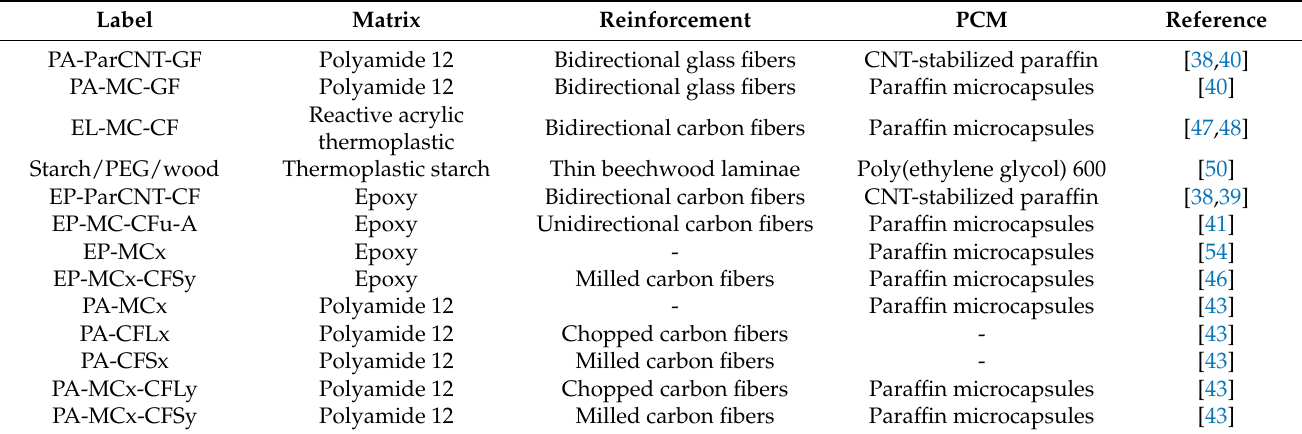
Table 3. Multifunctional composites under investigation in this paper with specifications of matrices, reinforcing agents, and